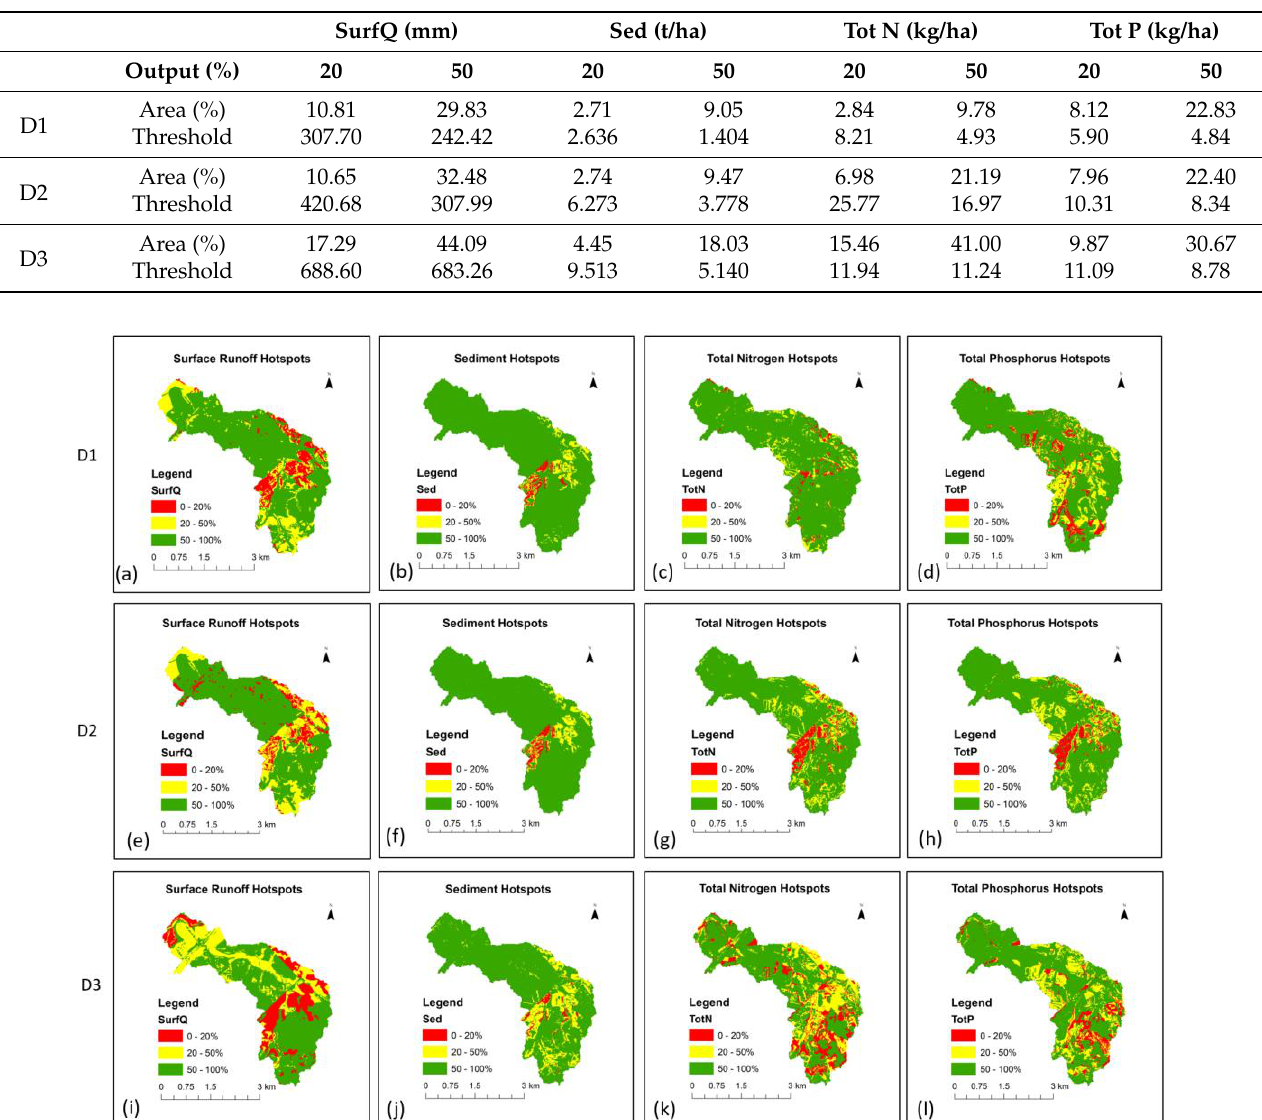
Table 5. Hotspots thresholds in three synthetic watersheds.